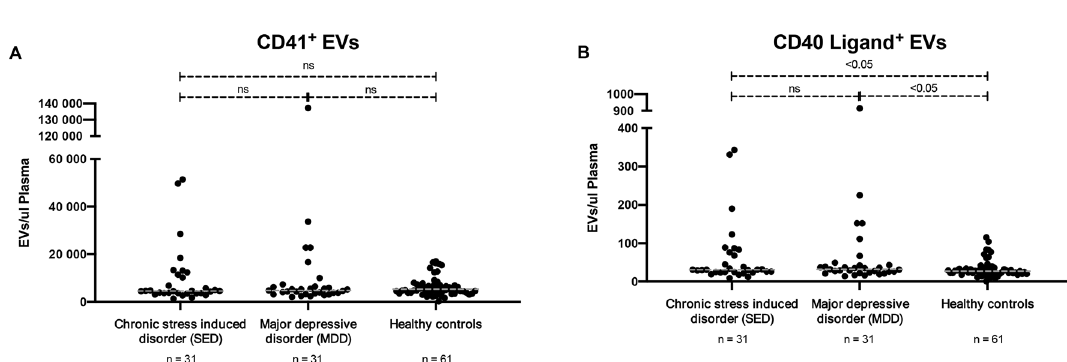
Figure 2. ( A – C ) Astrocyte-derived extracellular vesicles (EVs) expressing aquaporin 4 (AQP4) ( A ), glial fibrillary acidic protein (GFAP) ( B ), or both AQP4 and GFAP ( C ) in patients with stress-induced exhaustion disorder, patients with major depressive disorder, and healthy controls.